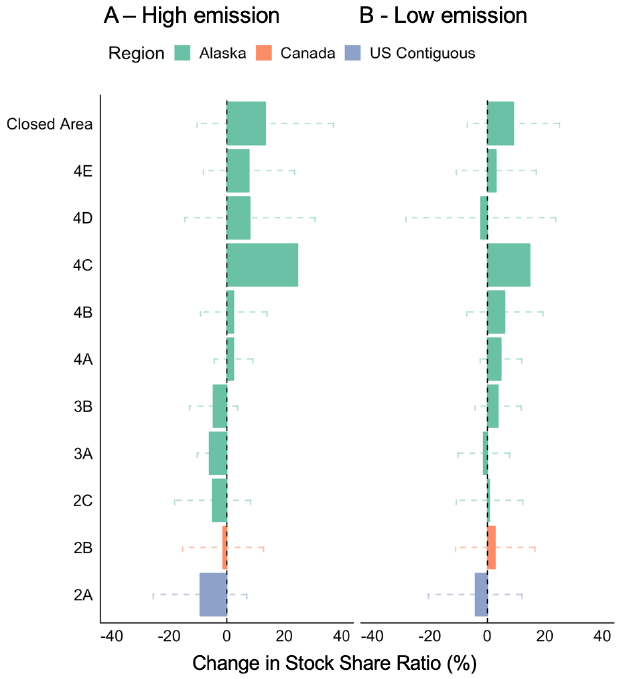
Fig. 3 . Percentage change of stock-share ratio for International Pacific Halibut Commission under (A) high emission scenario and (B) low emission scenario for mid-21st century (2041–2060) relative to the present 2005–2014. Values represent the mean of three Earth system models; error bars represent ±